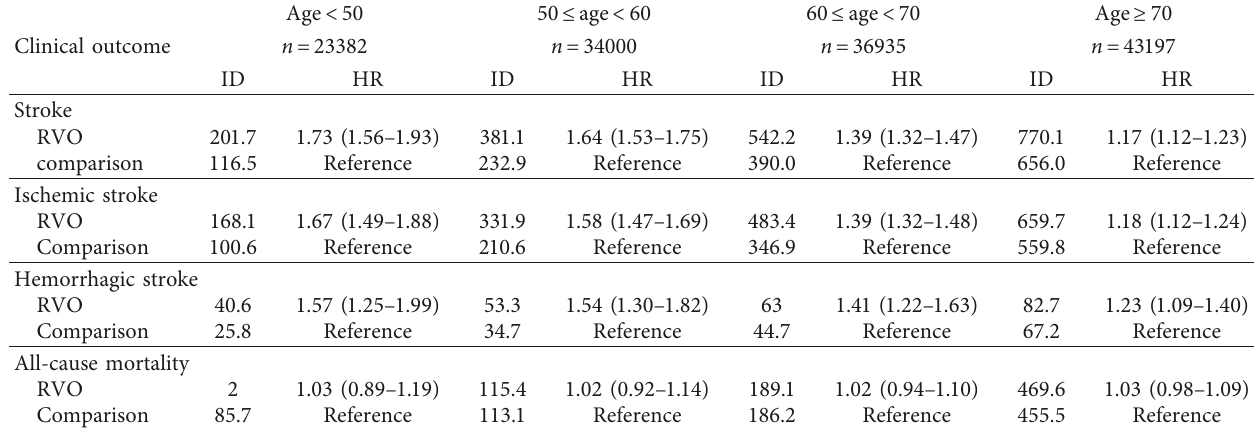
Table 3: Comparison of the risk for the clinical outcomes between the RVO and PS-matched comparison groups, stratified by age